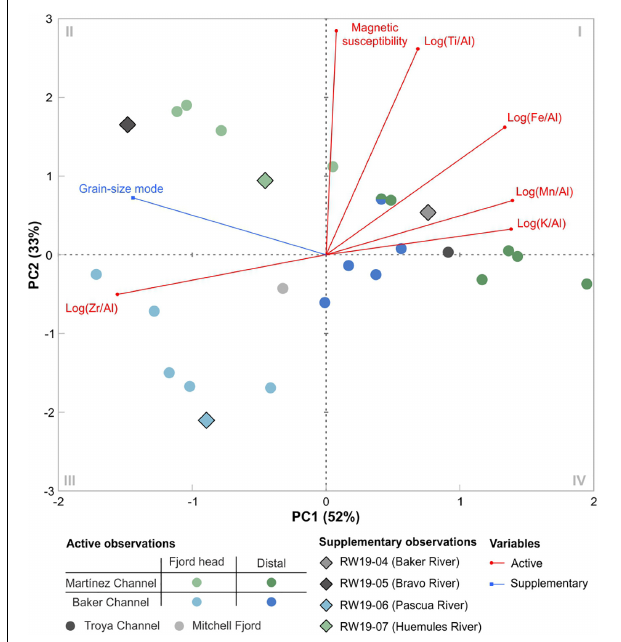
FIGURE 4 | Principal component biplot of the magnetic susceptibility and geochemical composition (active variables) of the fjord surface sediment samples (active observations) and projected river suspended sediment samples (supplementary observations). The grain-size mode is projected in the biplot (supplementary